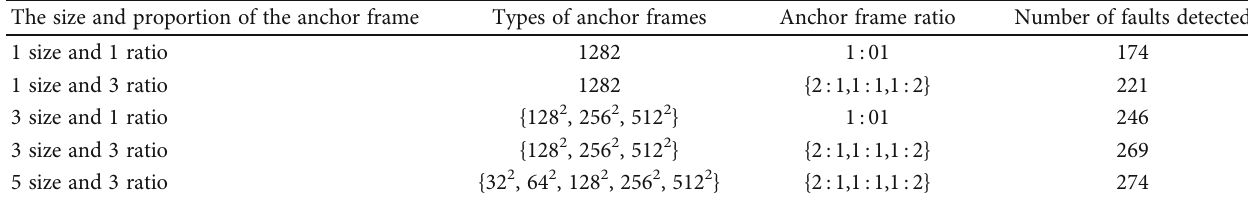
Table 4: Di ff erent sizes and di ff erent proportions of the anchor frame on the fault test results. The size and proportion of the anchor frame Types of anchor frames Anchor frame ratio Number of faults